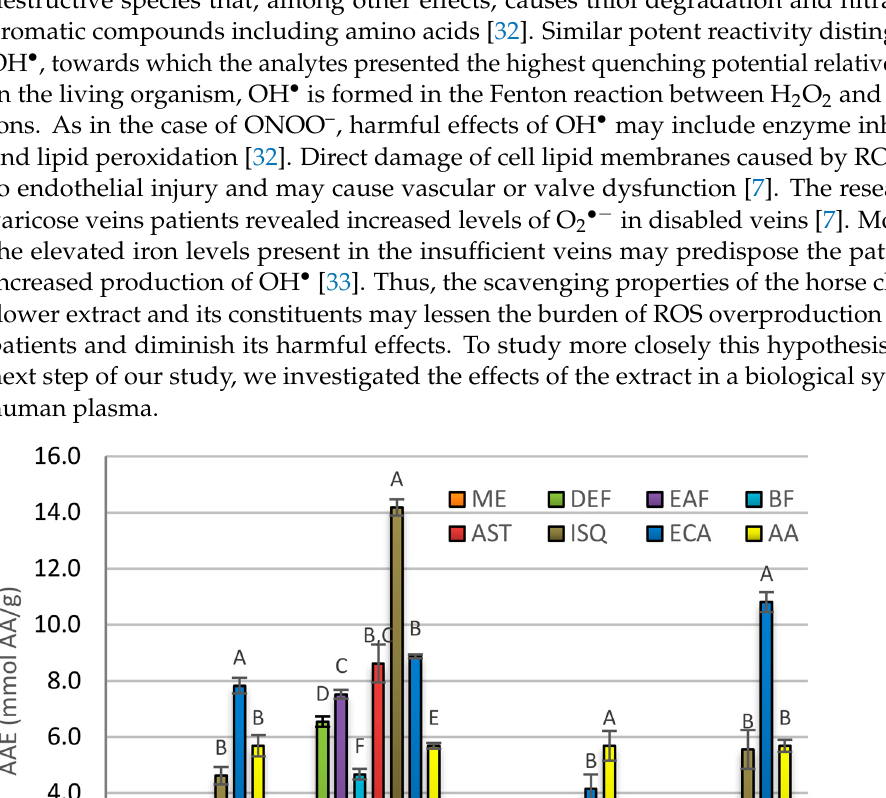
Table 3. Scavenging activity of the dry extracts from the flower of A. hippocastanum towards selected reactive oxygen species.